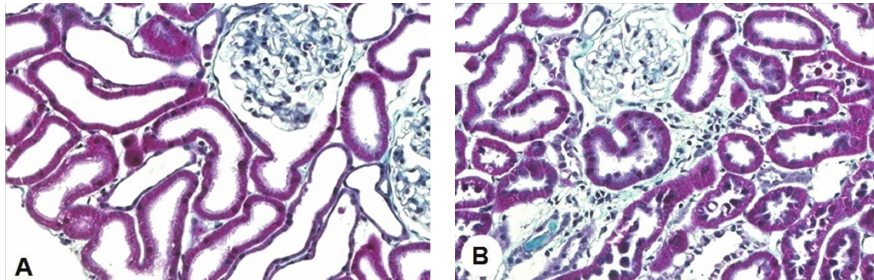
Figure 3: Masson’s trichrome stained histological sections of renal cortex of rats from dams submitted to high-sodium intake (B) and of the same age control rats (A) at 120 days of age (original magnification